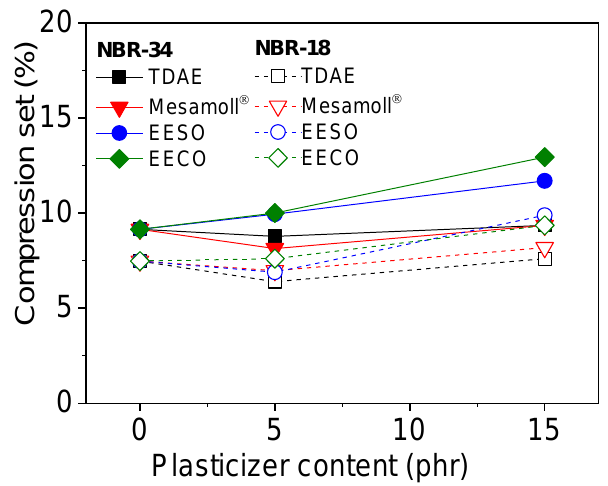
Figure 8. Compression set (CS)values as a function of plasticizer content for NBR vulcanizates.